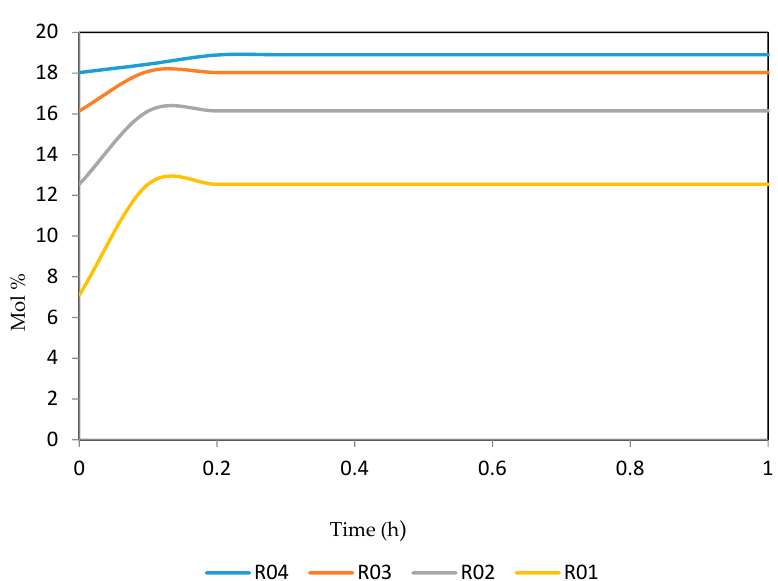
Figure 28. Dynamic behaviour of A 8 in the four reactors.